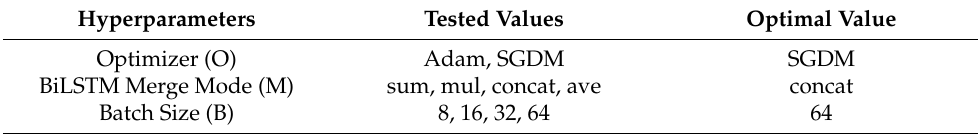
Table 3. Summary of hyperparameter tuning.